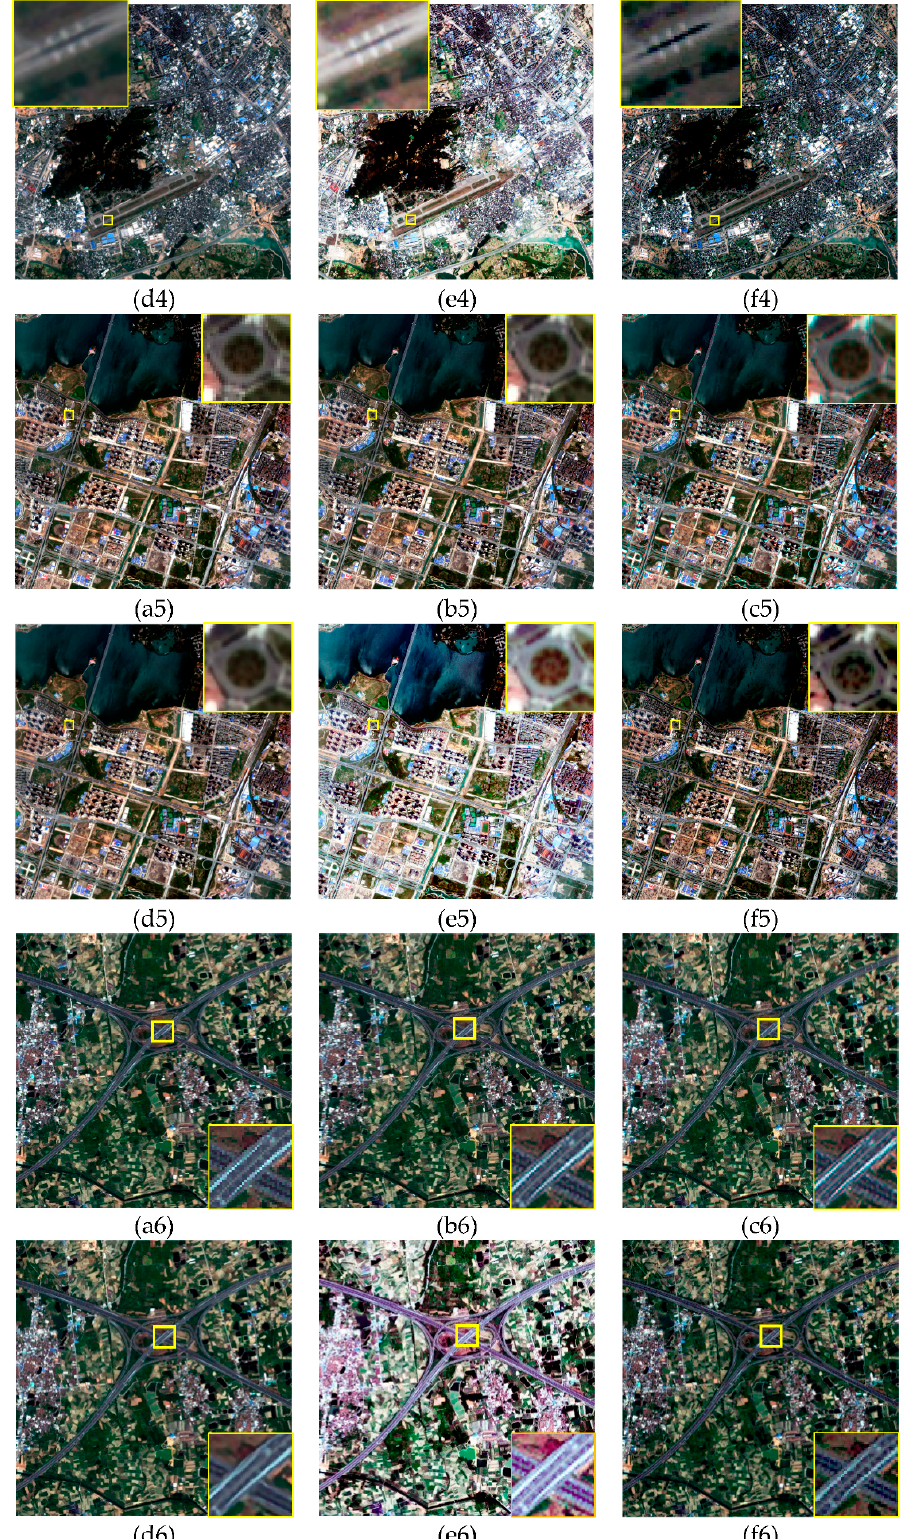
Figure 7. Comparison of image-reconstruction results of proposed method with other methods for 2× SR: ( a ) Bicubic; ( b ) IBP; ( c ) SRCNN; ( d ) VDSR; ( e ) HE; ( f ) MMSDB-SR.